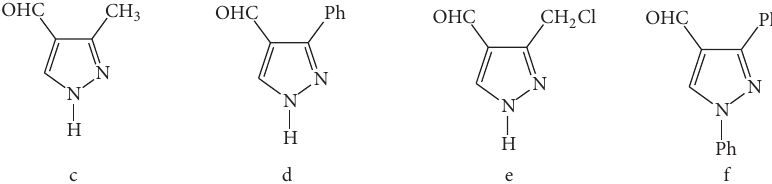
Scheme 2: Chemical structures of pyrazole aldehydes: c : 3-methyl-1 H -pyrazole-4-carbaldehyde; d : 3-phenyl-1 H -pyrazole-4-carbaldehyde; e